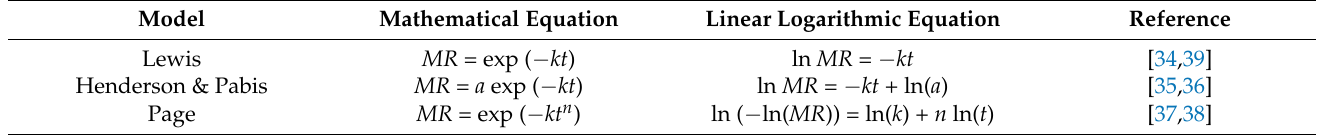
Table 1. Thin-layer drying models employed to model medicinal plant drying in this work.